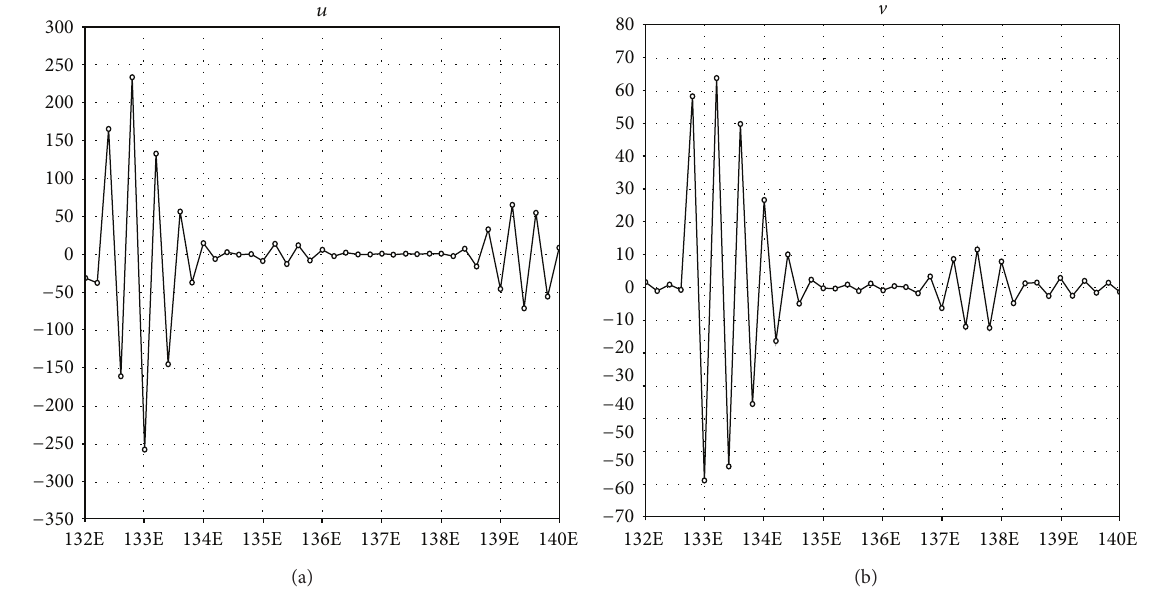
Figure 2: The figures show the values of the zonal velocity 𝑢 and the meridional velocity V at the latitude 30 ∘ N after running the model with 30 steps.